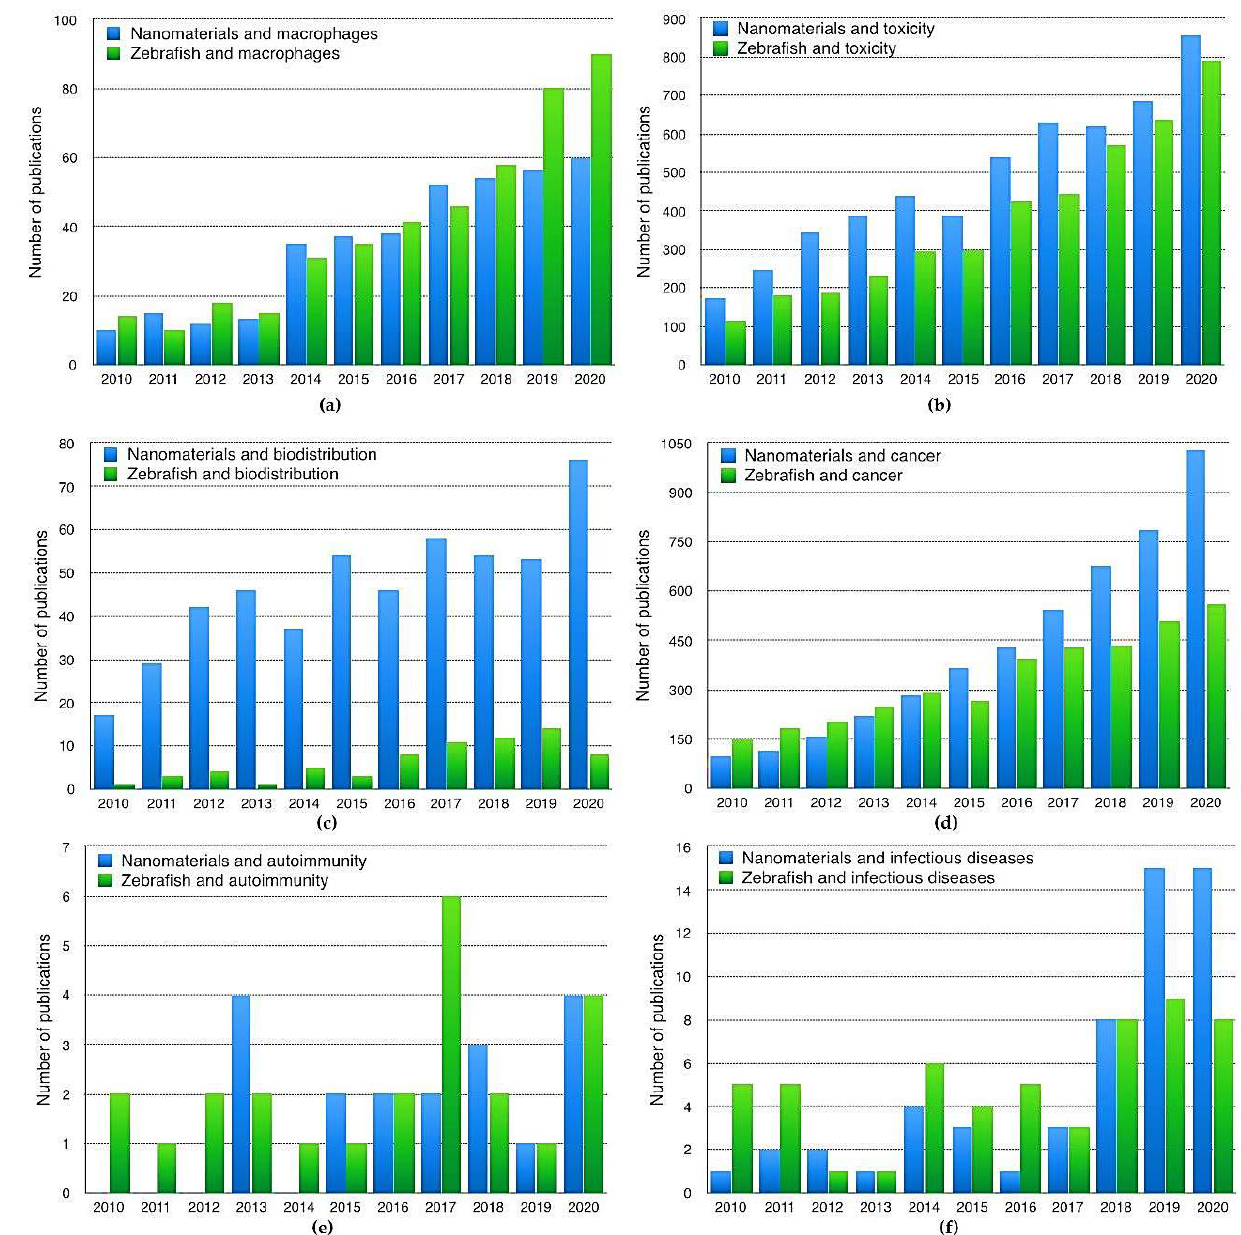
Figure 3. Number of publications each year in Pubmed for indicated terms from 2010 to 2020: ( a ) Nanomaterials and macro- phages/Zebrafish and macrophages; ( b ) Nanomaterials and toxicity/Zebrafish and toxicity; ( c ) Nanomaterials and biodis- tributrion/Zebrafish and biodistribution; ( d ) Nanomaterials and cancer/Zebrafish and cancer; ( e ) Nanomaterials and autoimmun- ity/Zebrafish and autoimmunity; ( f ) Nanomaterials and infectious diseases/Zebrafish and infectious diseases.